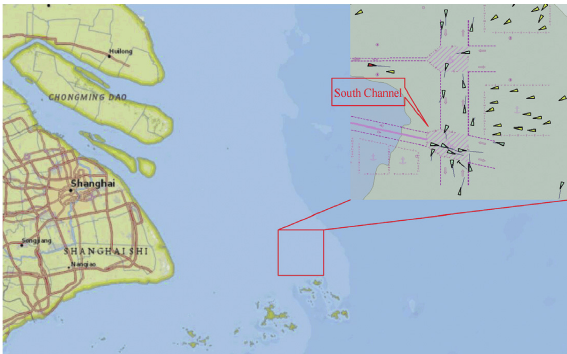
Figure 6: Electronic chart of the South Channel intersection waterway of the Yangtze Table 3: Records of time windows.